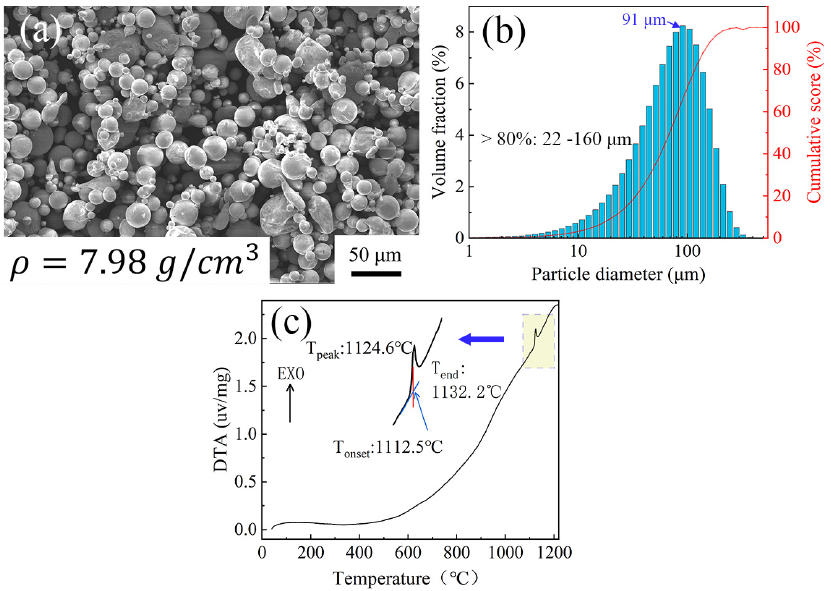
Figure 1. SEM image, particle diameter distribution bar graph and DTA curve of interlayer powder: